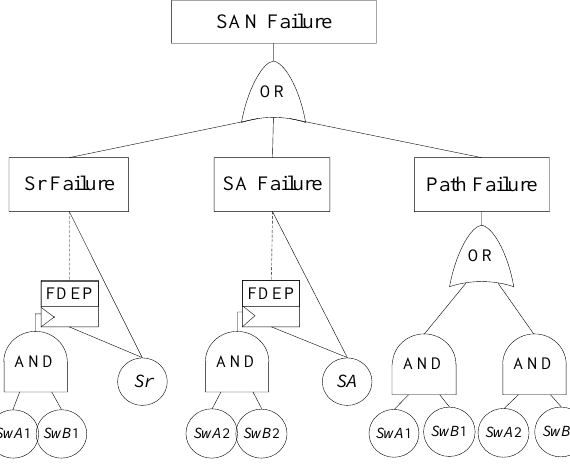
Figure 2. DFT model of the example mesh